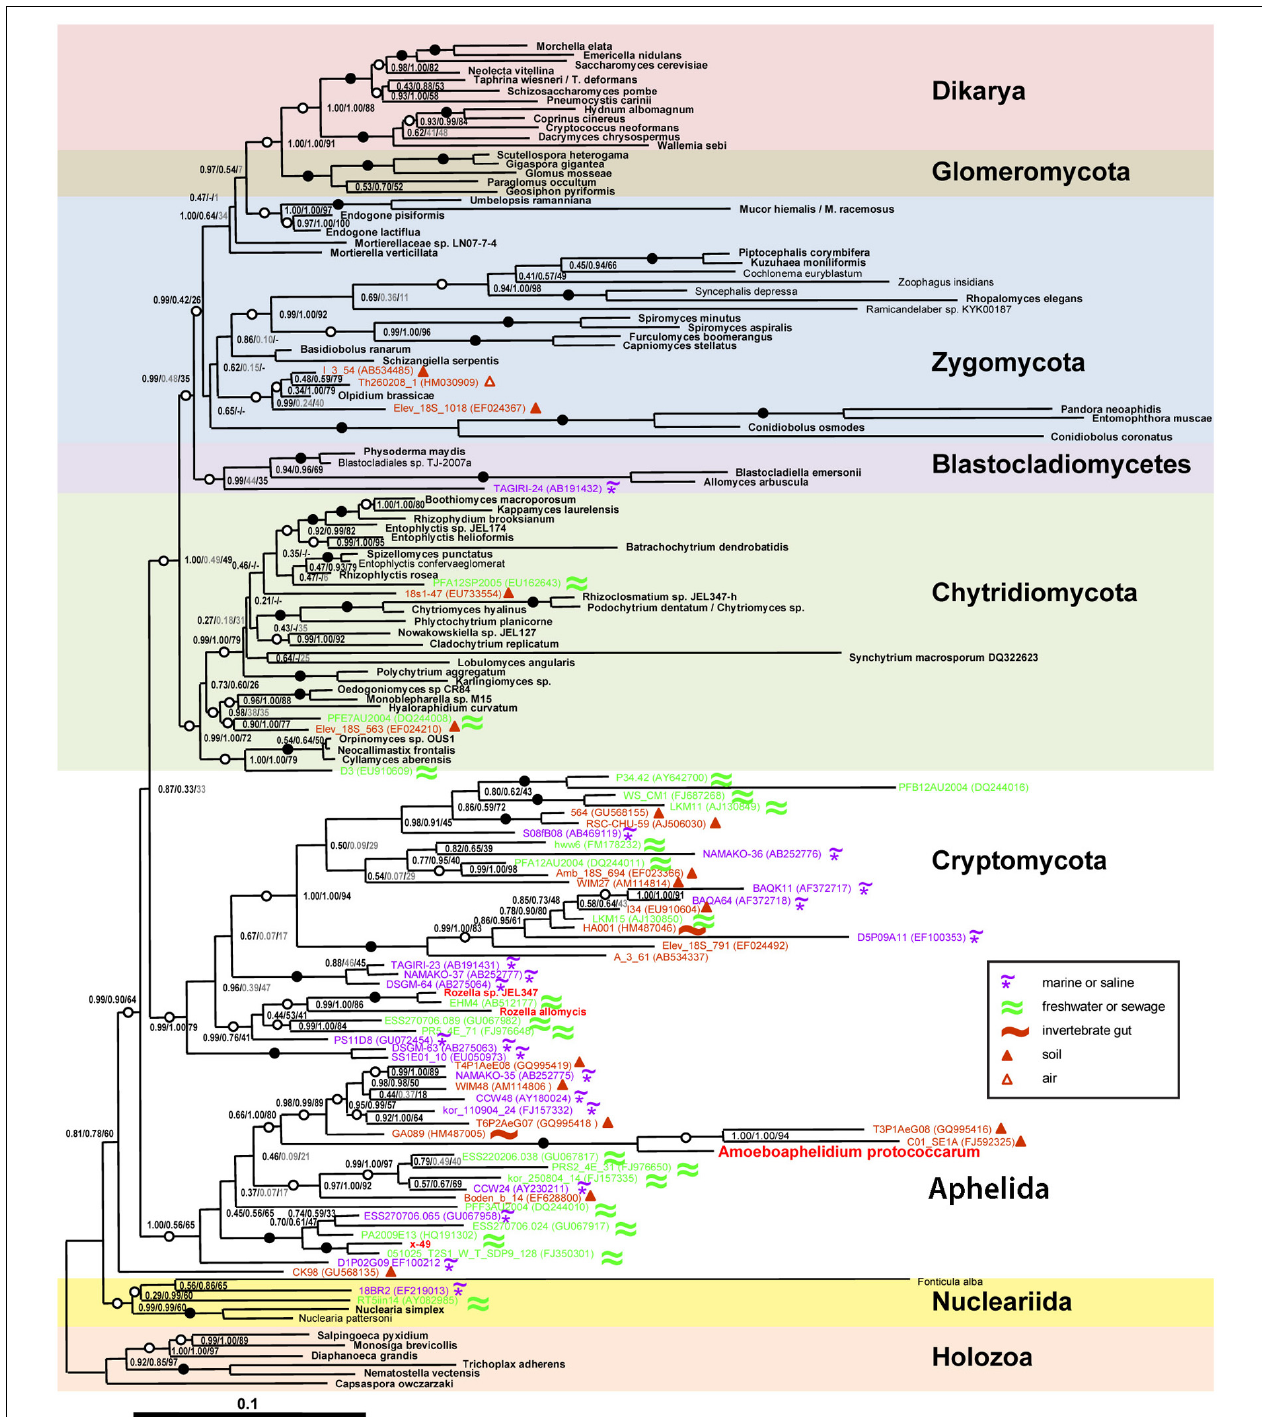
FIGURE 1 | Position of Amoeboaphelidium protococcarum on the tree inferred from rDNA analyses by Bayesian and ML methods (after: Karpov etal., 2013). PhyloBayes tree topology was calculated from an alignment of 144 sequences and 4,384 nucleotide characters. Node support values are given as follows: Bayesian posterior probabilities (PhyloBayes/MrBayes) followed by bootstrap values (RAxML). We used the GTR + CAT model without partition by genes for PhyloBayes